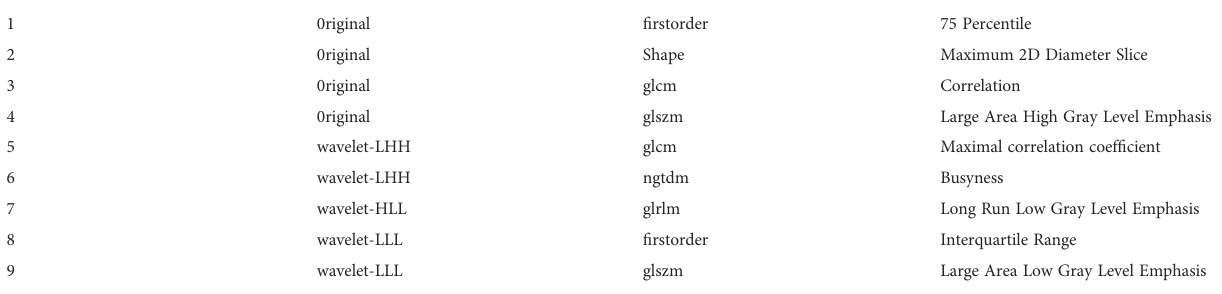
TABLE 3 Selected radiomic features in training